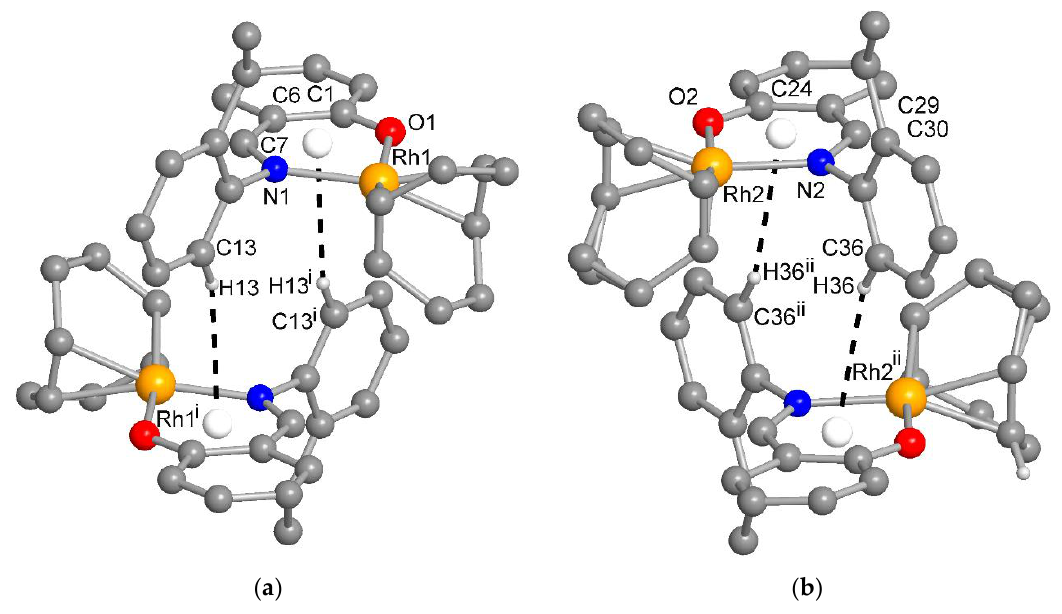
Figure 6. The reciprocal or pairwise C-H···metallochelate- π contacts between a pair of each of the symmetry-independent molecules in 1 with Rh1 ( a ) and Rh2 ( b ) (distance and angle details are given in Table S1). For clarity, the H atoms were omitted except for those of the C-H··· π contact. Symmetry transformation i = –x, 1–y, 1–z; ii = 2–x, 1–y, Table 3. Selected bond lengths [Å ] and angles [°] in the X-ray and optimized structures for HL 2 , 1 and 2 .